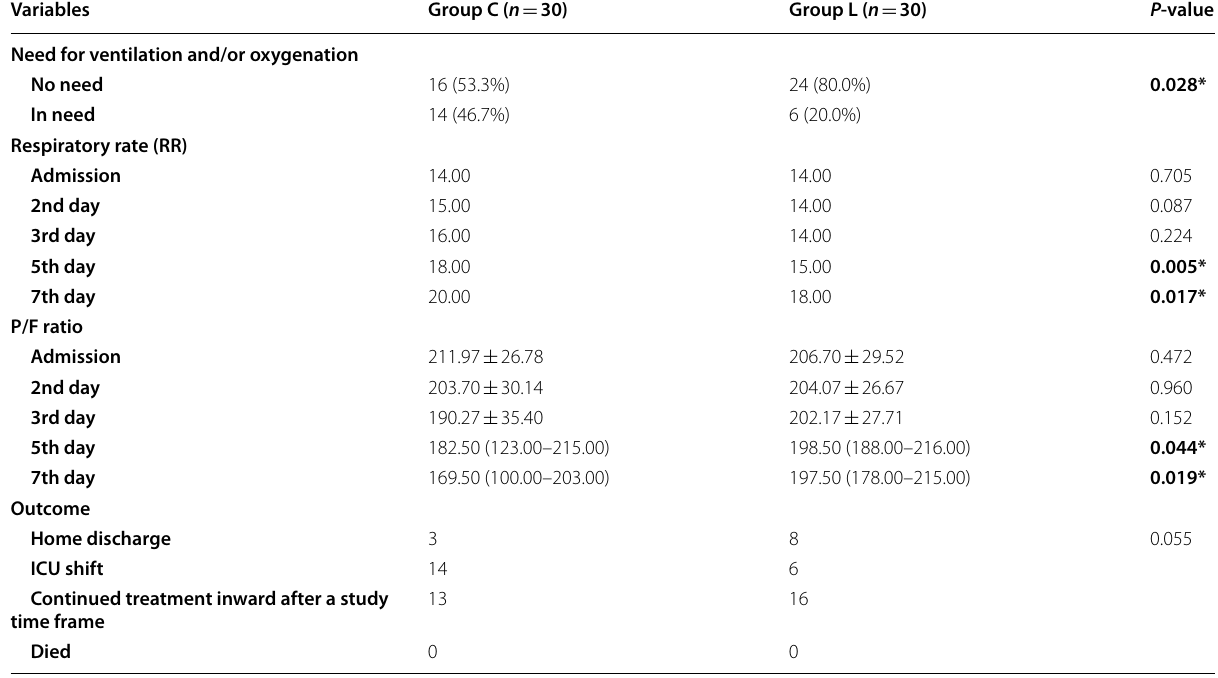
Table 3 Oxygenation and ventilation variables, respiratory rate (RR), and outcome in the two study